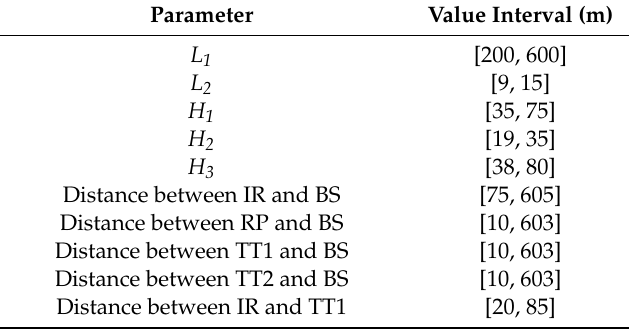
Table 1. Distances of parameters shown in Figure 4 and derivations. IR: Inspection Robot, BS: Base Station, TT1: Trimming Terminal 1, TT2: Trimming Terminal 1.